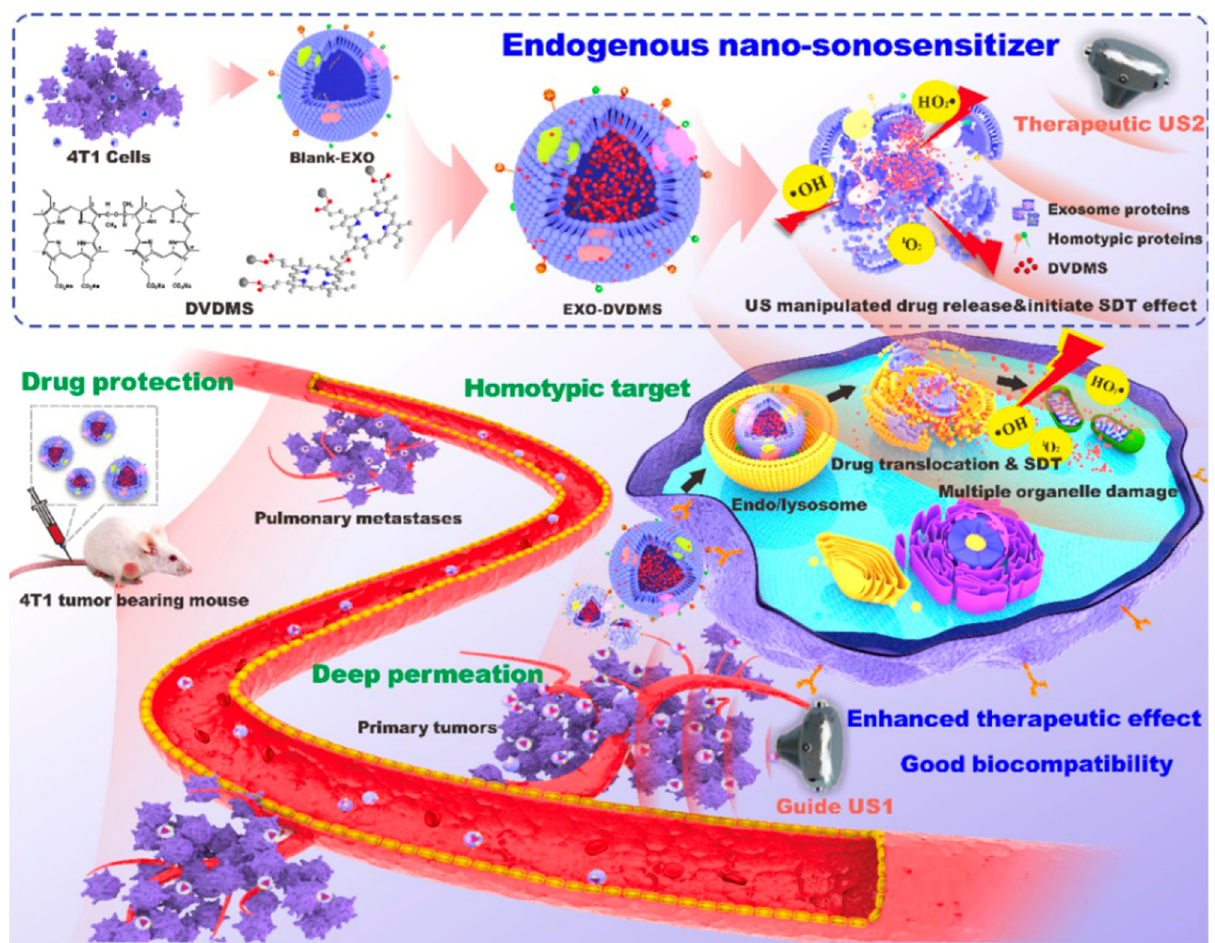
Figure 2: Endogenous nanosonosensitizers enhance SDT e ffi cacy. Reproduced with permission [ 25 ] . Copyright 2019, the author ( s )